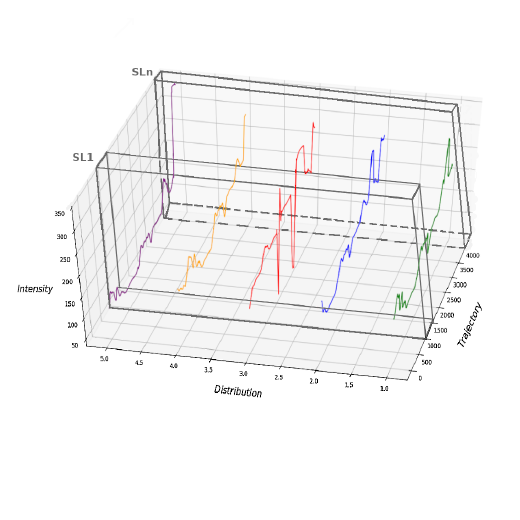
Figure 1. Predefined segment from the light intensity